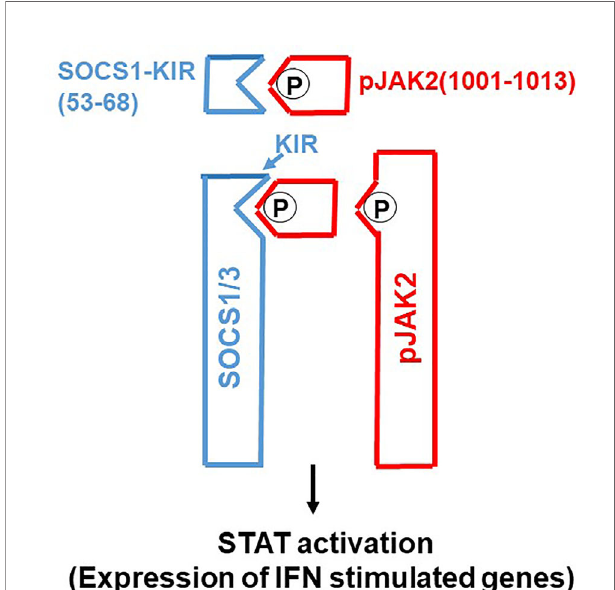
FIGURE 1 | SOCS1/3 antagonist. Scheme of how SOCS1/3 antagonist, pJAK2 (1001-1013), inhibits SOCS1 and 3 blockage of activation of JAK2 (or (TYK2) for induction of antiviral activity of interferon. P, indicates